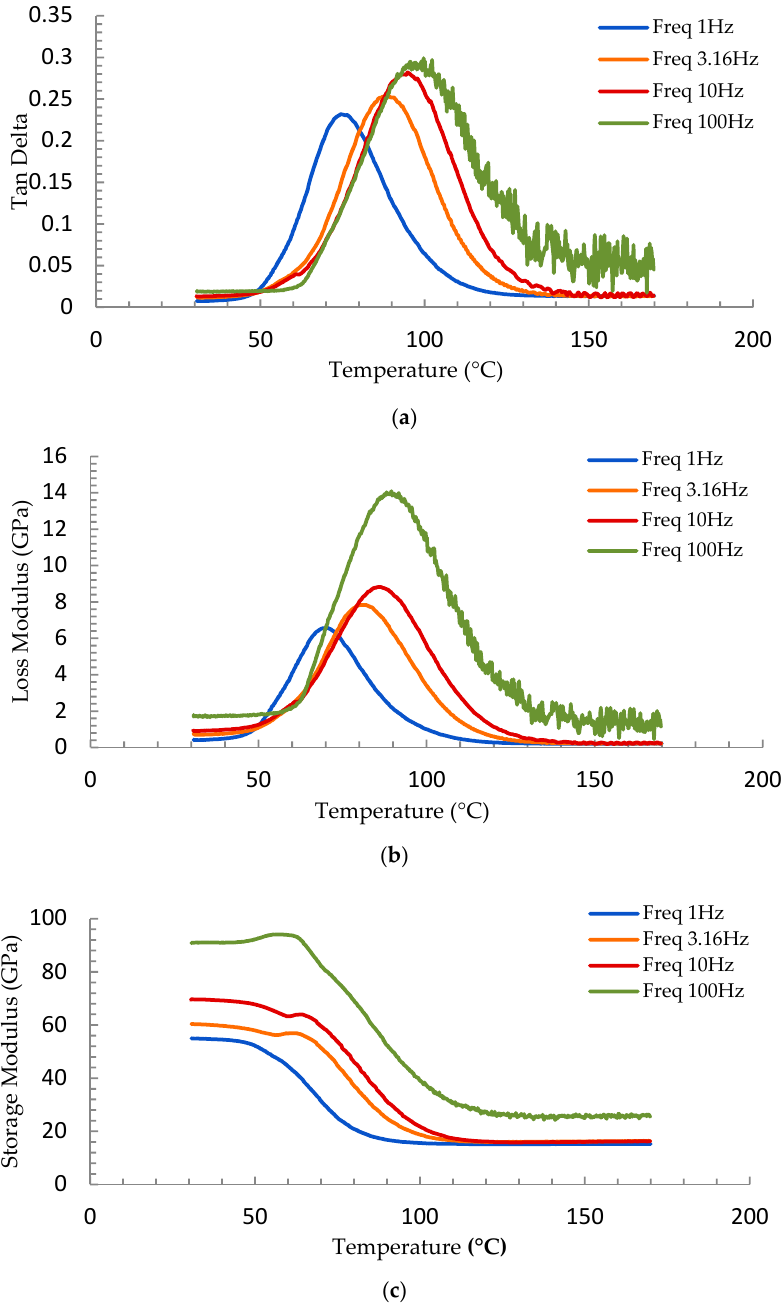
Figure 4. The viscoelastic properties of the various composites’ configurations under frequency sweep at 30 °C. ( a ) Tan delta, ( b ) Loss modulus, and ( c ) Storage modulus.